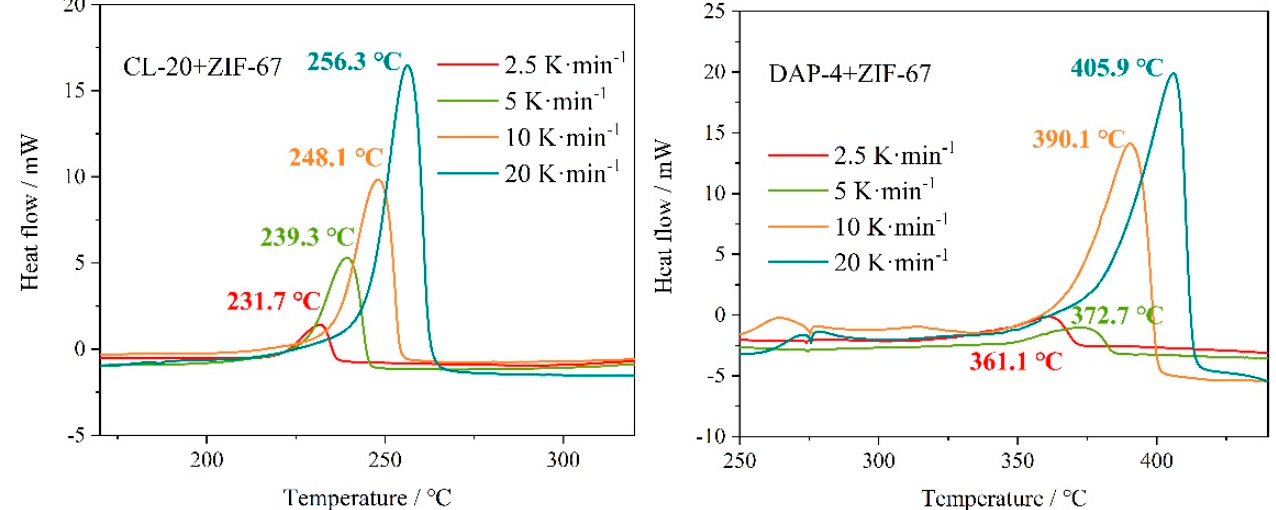
Figure 9. DSC curves for RDX, HMX, CL-20 and DAP-4 under ZIF-67 catalytic conditions at different heating rates.